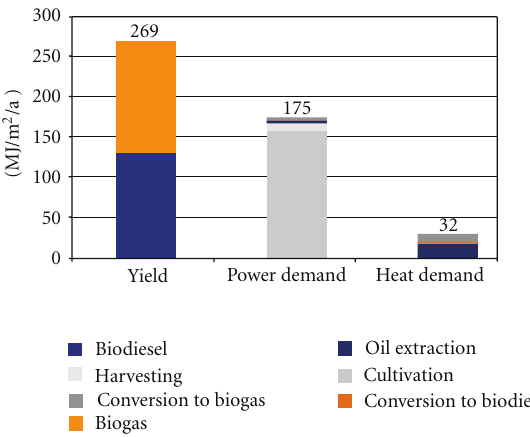
Figure 8: Comparison of energy yield and energy consumption for biodiesel and biogas production from microalgae applying closed photobioreactors (solar radiation 7,000 MJ/m 2 /a).